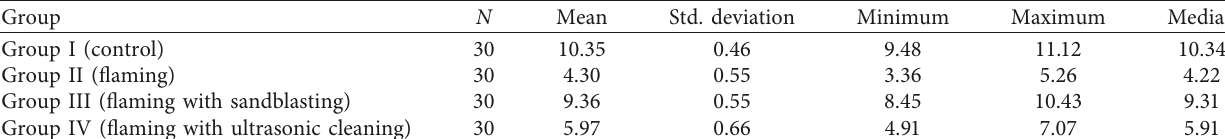
Table 1: Shear bond strength mean values (in MPa) of different groups.